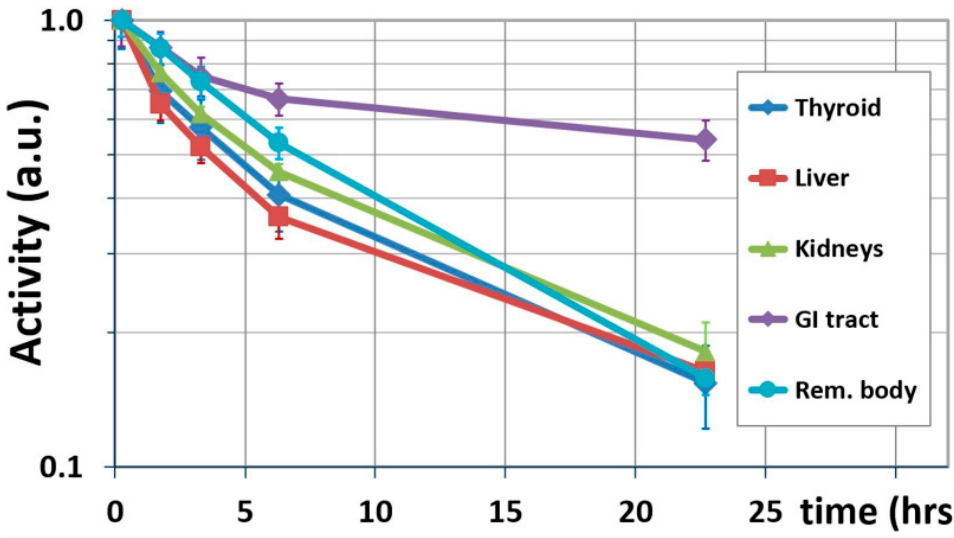
Figure 2. Biological washout of IAZA from source organs (mean from 6 healthy volunteers). Washout decreases activity to below 20% for all organs by ~21 h p.i. except the GI tract, where the last time point is at 54% of the initial activity. Table 2. Terminal biological half-life of source organs determined by exponential fit to the last two data points ( 𝑡 (cid:2872) and 𝑡 (cid:2873) ) in Figure 2.